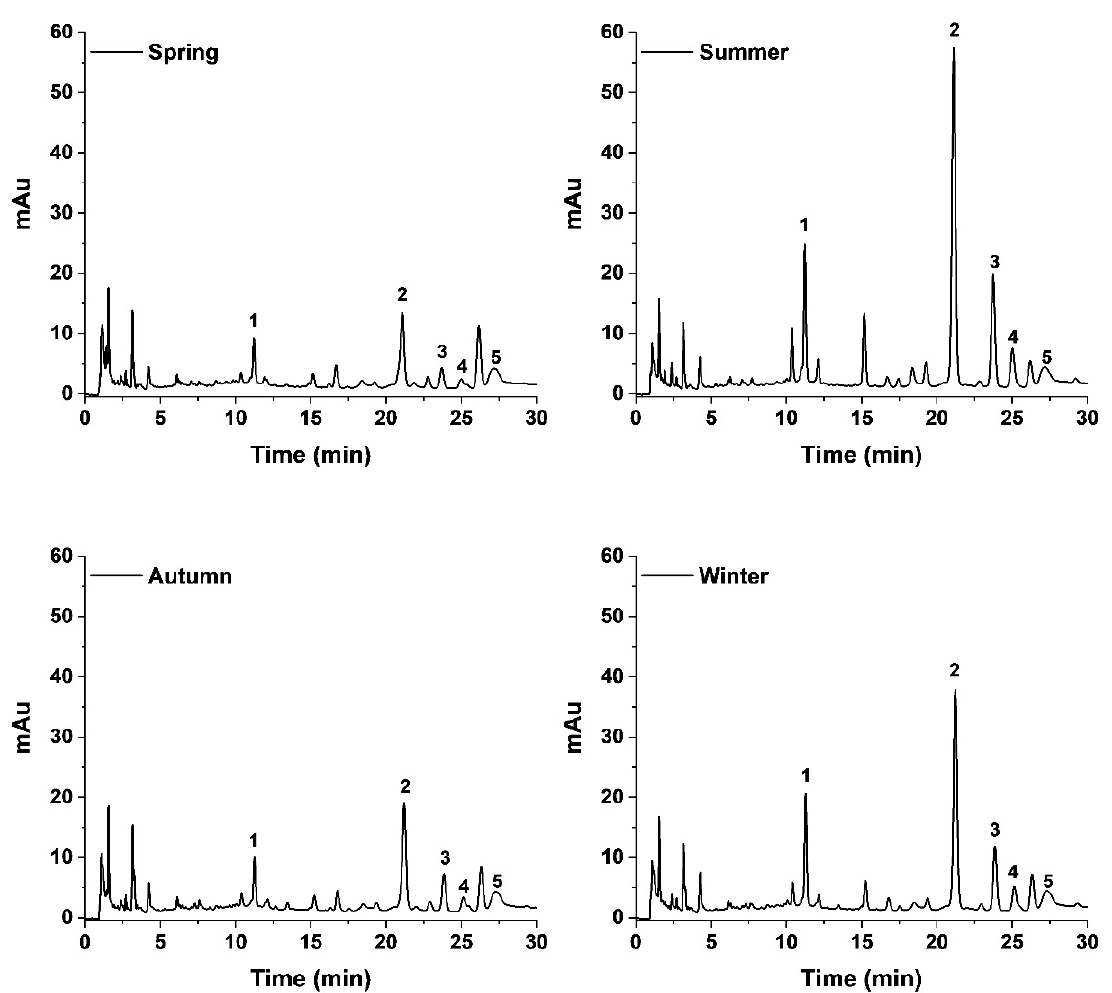
Figure 2. Polyphenolic profile of seasonal samples of SP-AgNPs. Five main constituents of Sonoran propolis were identified: quercetin (1), pinocembrin (2), pinobanksin-3-O-acetate (3), chrysin (4), and galangin (5). mAu: milli-absorbance units.